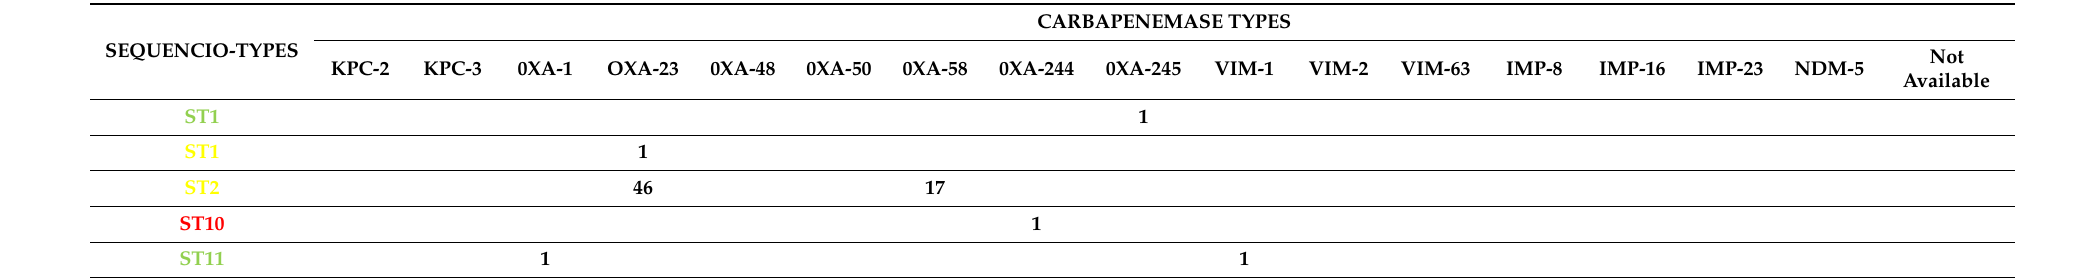
Table 3. Description in the microorganisms of carbapenemase and sequence